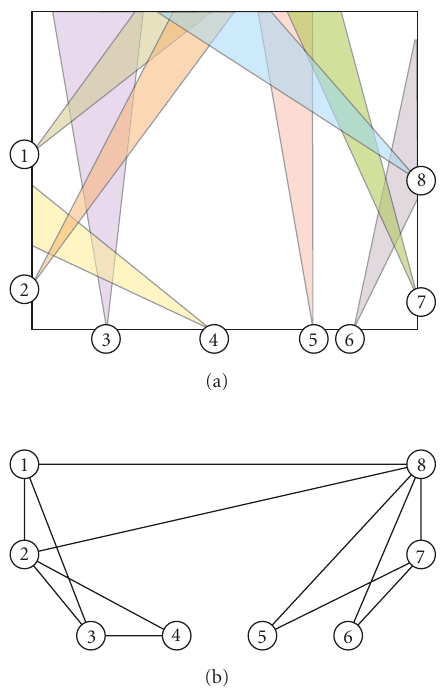
Figure 1: (a) A snapshot of the instantaneous state of a camera net- work, indicating the fields of view of eight cameras, (b) the associ- ated vision